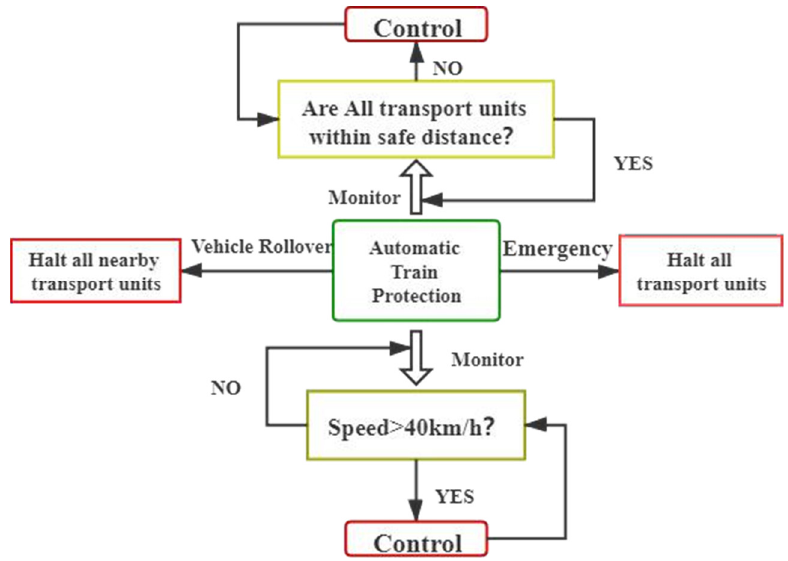
Figure 4. The control function and working principle of the ATP system in the intelligent under- ground mine.